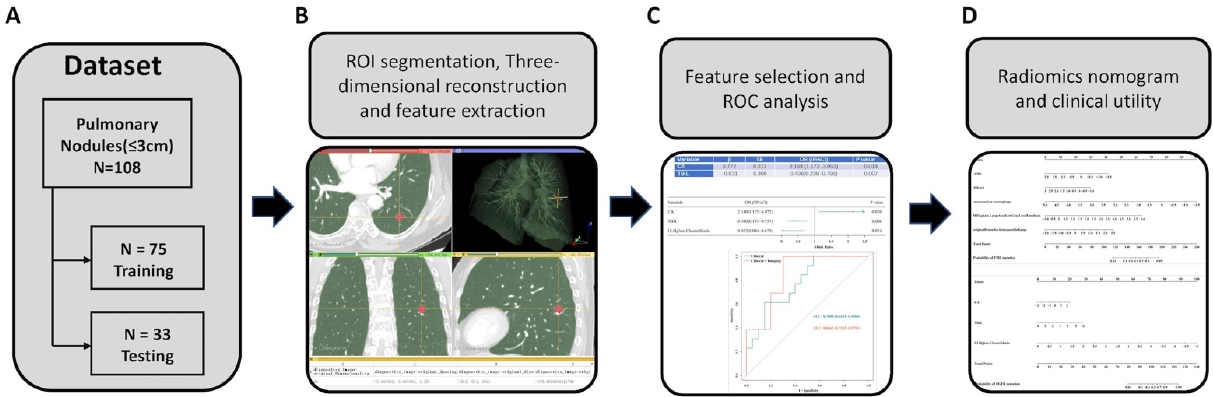
Figure 1. Study workflow overview. ( A ) Patient’s enrollment. ( B ) Region of interest (ROI) segmentation of pulmonary nodules and acquisition of radiomic features. ( C ) Feature selection and performance of the receiver operating characteristic (ROC) curve. ( D ) Performance of the radiomics nomogram and clinical utility.